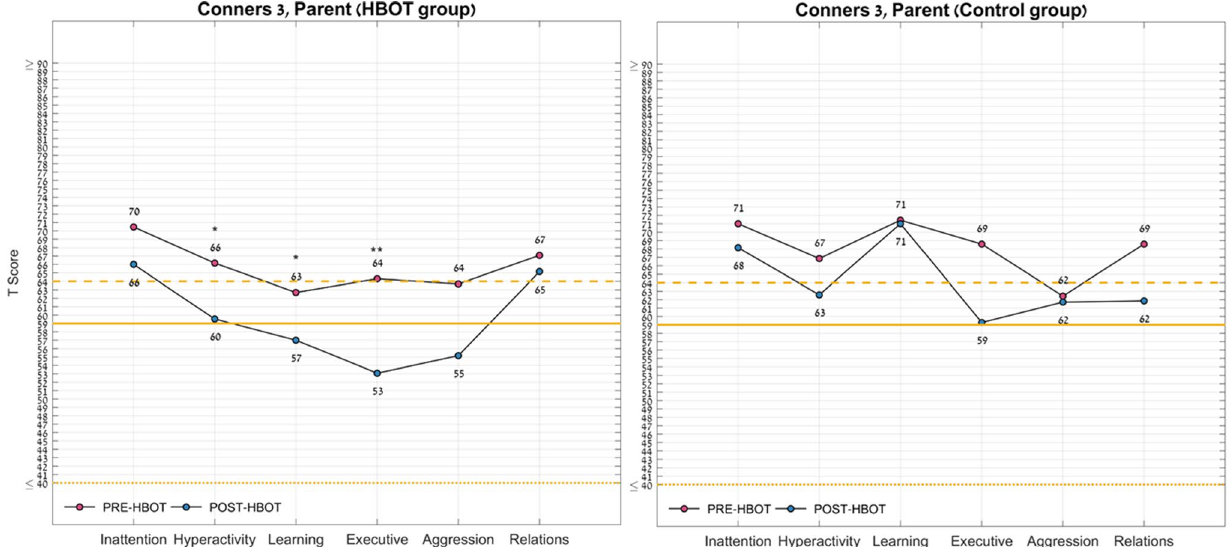
Figure 3. Conners scale for assessing ADHD questionnaire domains change. Following HBOT, the Conners 3 questionnaire showed significant improvements in the hyperactivity score, executive score, learning problem score and negative impression. Normal range [40–59]. *P < 0.05; **P < 0.01; See Table 4 for full statistical